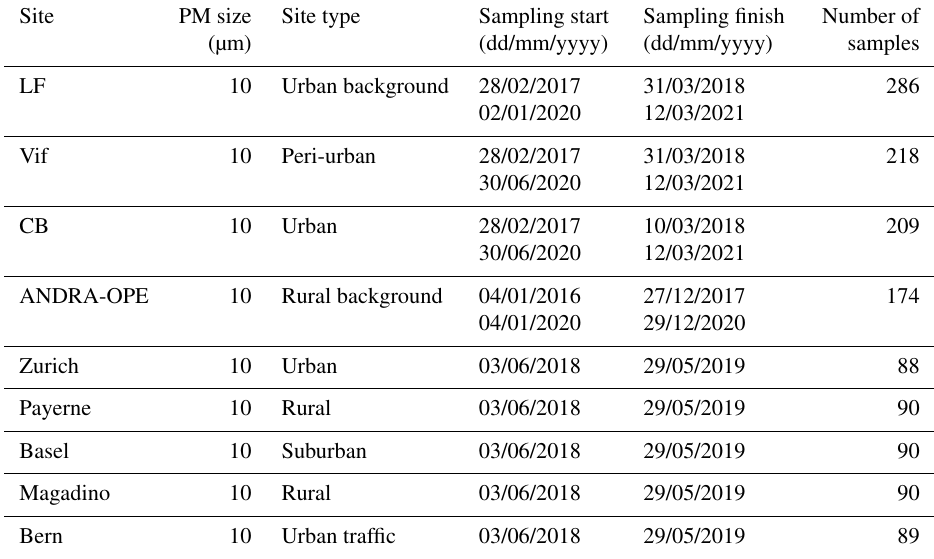
Table 1. Sampling period and site characteristics for the PM 10 sampling campaign. LF: Les Frênes, CB: Caserne de Bonne. LF, CB, and Vif represent sites from the Grenoble metropole.